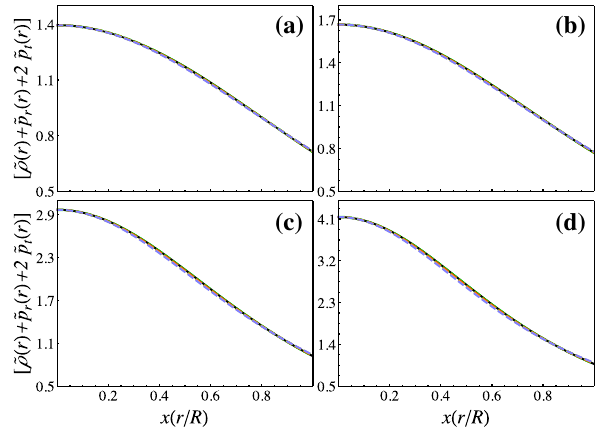
Fig. 4 Anisotropic factor , for a u = 0 . 13, b u = 0 . 15478, c u = 0 . 2035, d u = 0 . 229365. α = 0 (black solid line), α = 0 . 04, (green dashed line), α = 0 . 1 (red dashed line), α = 0 . 2 (yellow dashed line), α = 0 . 3 (blue dashed line)